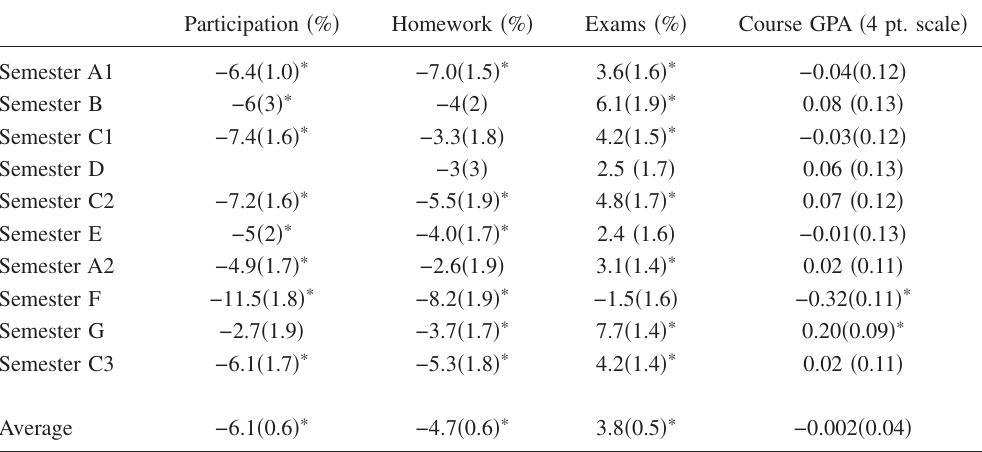
TABLE V. Analysis of students’ course grades. Each column contains the difference between the average scores for males and females (cid:1)(cid:5) S (cid:6) M − (cid:5) S (cid:6) F (cid:2) . Error (cid:1) shown in parentheses (cid:2) is computed from the standard errors of the mean for males and females added in quadrature. The asterisk (cid:1) (cid:1) (cid:2) indicates that the difference is statistically significant at the p (cid:1) 0.05 level. In Semester D no participation credit was given.